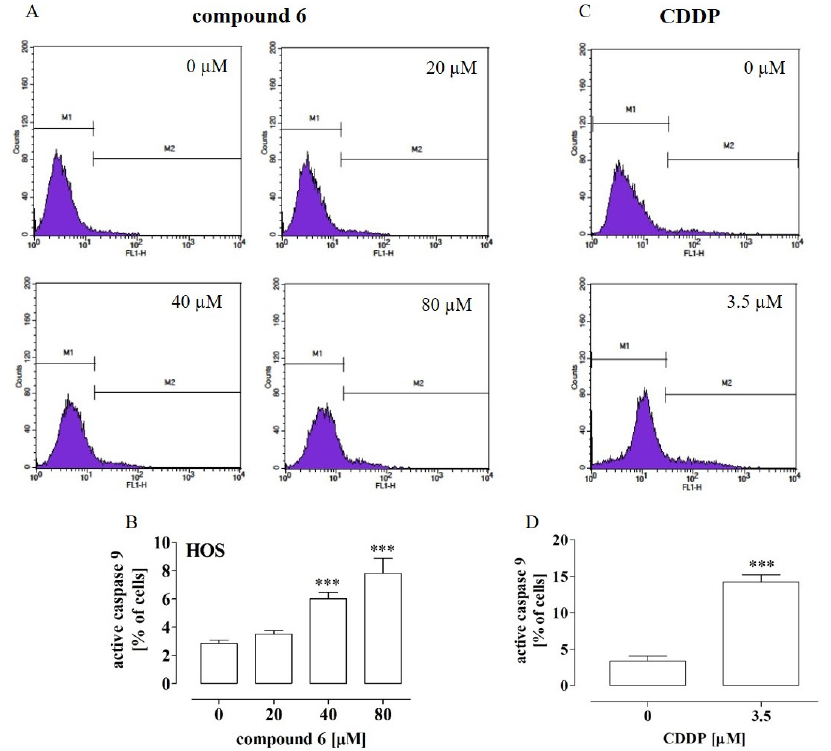
Figure 4. Effect of compound 6 and cisplatin (CDDP) on caspase 9 activation in HOS cells. The cells were treated with the compound at the indicated concentrations for 72 h. The histograms ( A , C ) are representative and correspond with the percentage of cells with active caspase 9 (M2 gate) detected by flow cytometry after cell staining with the fluorescein-conjugated inhibitor of active caspase 9 ( B , D ). The results are mean values ± SD of at least three independent experiments. Statistically significant differences: ***—at p < 0.001 in comparison with the untreated cells (one-way ANOVA followed by Dunnett’s post-hoc test or an unpaired